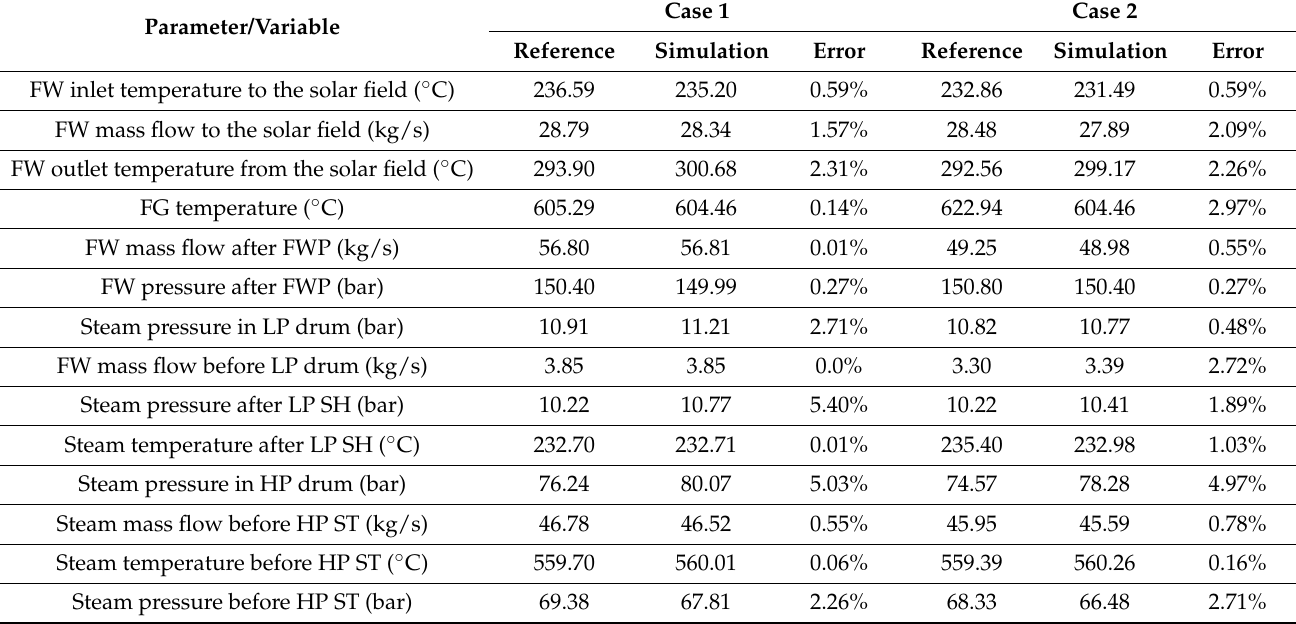
Table 6. Comparison between the simulation results and the operational design